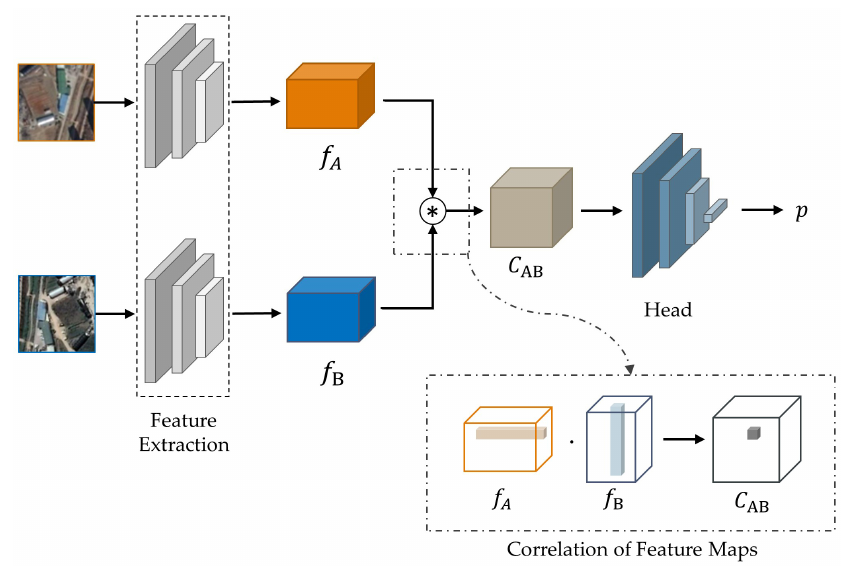
Figure 2. Architecture of ScoreCNN. c AB = (cid:104) f A , f B (cid:105) represents the scalar product in C AB , where f A ∈ f A , f B ∈ f B .